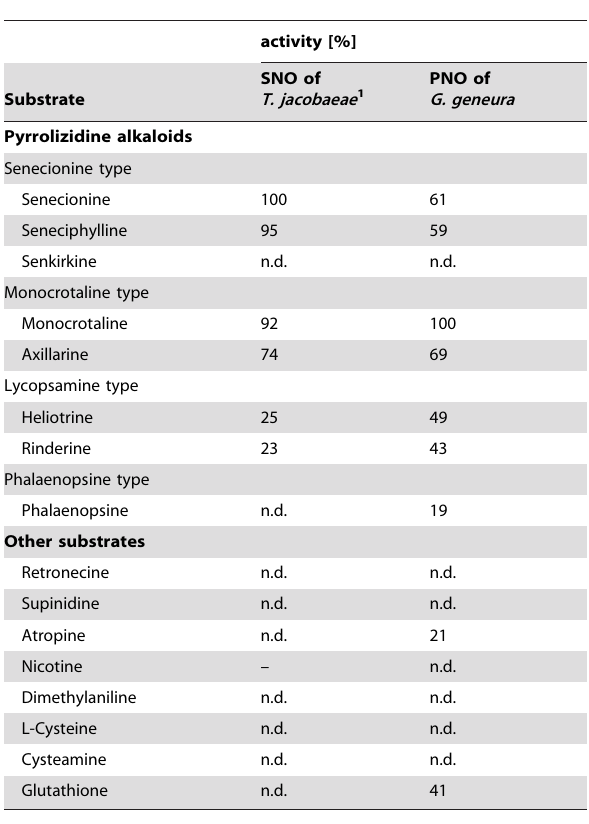
Table 2. Substrate specificity of native Tj SNO and recombinant Gg